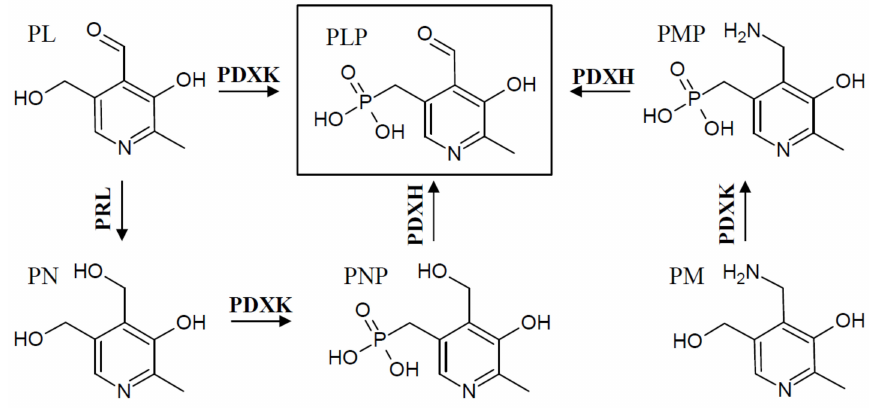
Figure 3. The VitB 6 salvage pathway. The salvage pathway is used to derivatize and phosphorylate B 6 vitamers, leading to PLP synthesis via oxidase (PDXH), kinase (K), and pyridoxal reductase (PRL)